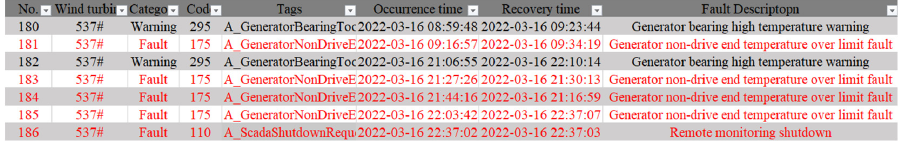
Figure 11. The result of the aerodynamic power prediction model on 16 March 2022.